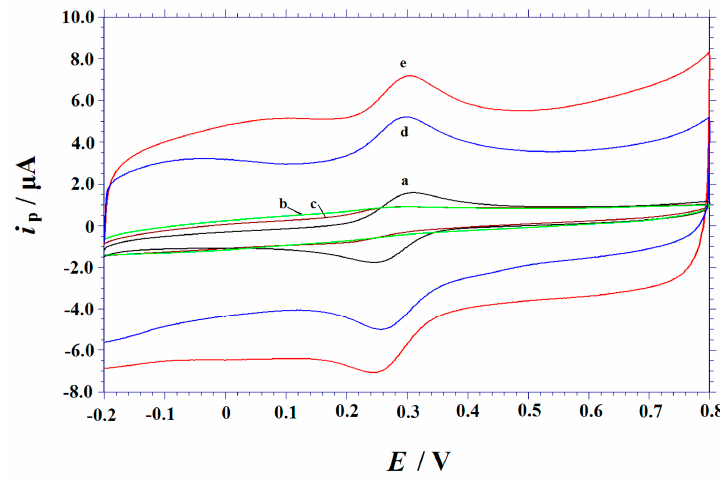
Figure 2. Cyclic voltammograms of 5 mM K 3 [Fe(CN) 6 ] in 1.0 M KCl for different electrodes: ( a ) bare glassy carbon electrode (GCE), ( b ) Cu 2 O/GCE, ( c ) GO/GCE, ( d ) ERGO/GCE, and ( e ) Cu 2 O-ERGO/GCE. Scan rate: 0.1 V s − 1